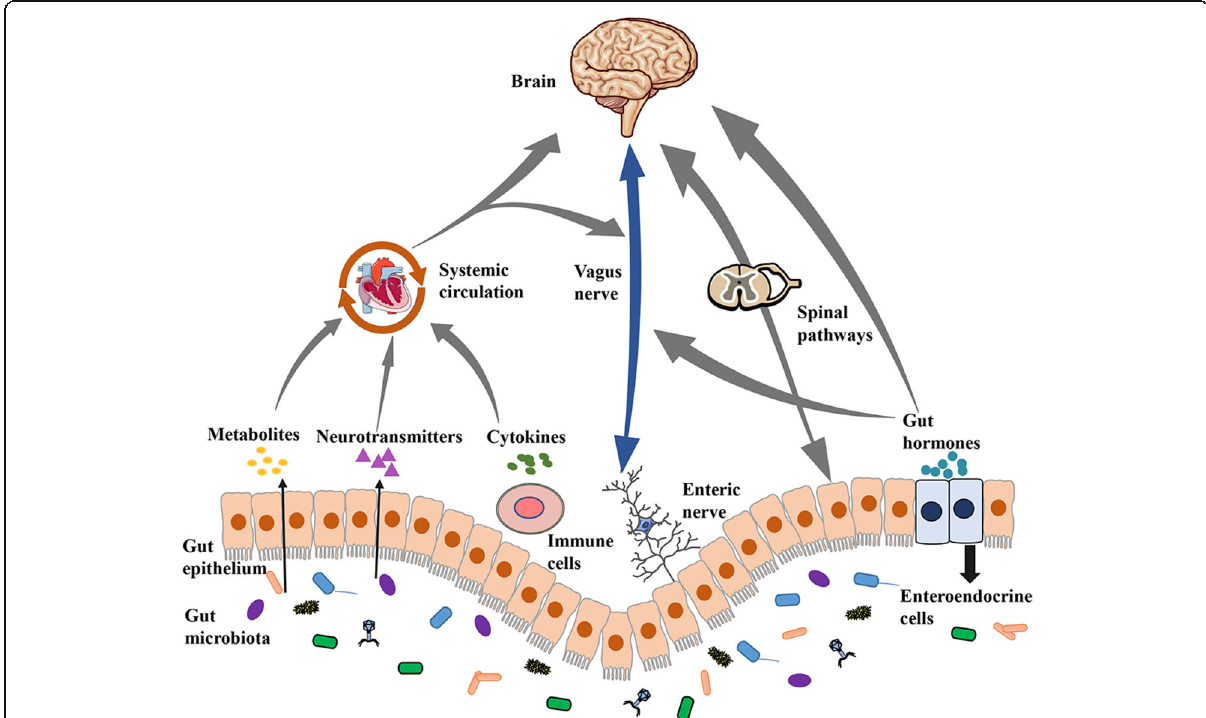
Fig. 1 Communication pathways of the microbiota-gut-brain axis. This graph describes the crosstalk of the microbiota-gut-brain axis, which mainly comprise of four modules: metabolic, neural, immune, and endocrine signaling